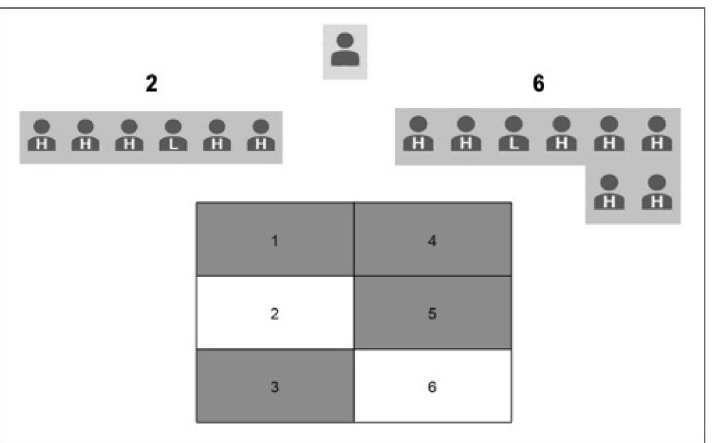
Figure 2. Choice screen on a trial in the social gambling phase. Participants use the left and right arrow keys to select slot 2 or 6, respectively. The participant is represented by the top middle avatar, and ostensible previous gamblers, labeled as either low earners (L) or high earners (H), are positioned under slot identifiers positioned at the top left and right of the screen. After making a selection, the participant’s avatar aligns with the previous players beneath the selected slot identifier.